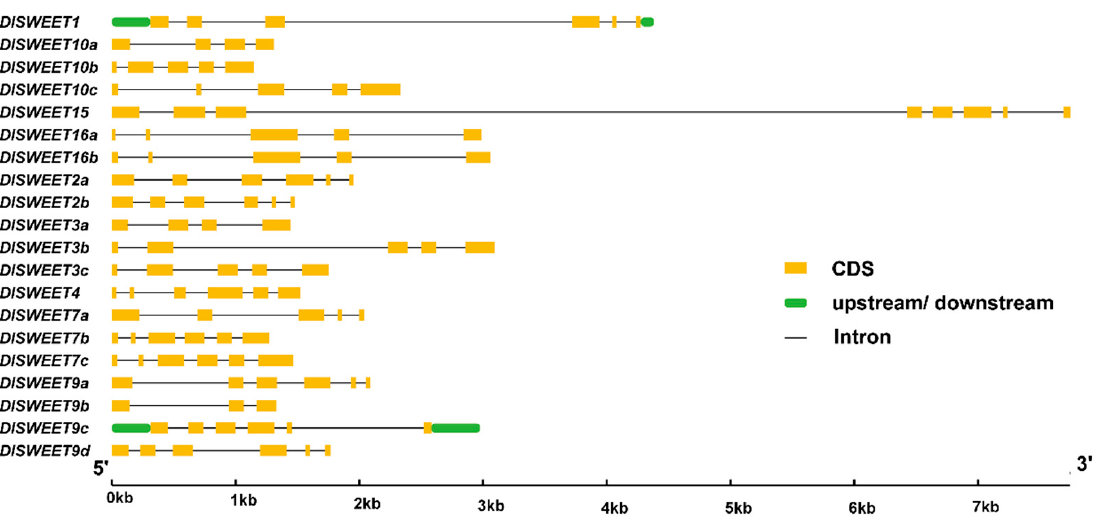
Figure 3. The gene structures of the DlSWEET genes, include introns (black lines), exons (CDSs, yellow rectangles), and untranslated regions (UTRs, green round-corner rectangles).